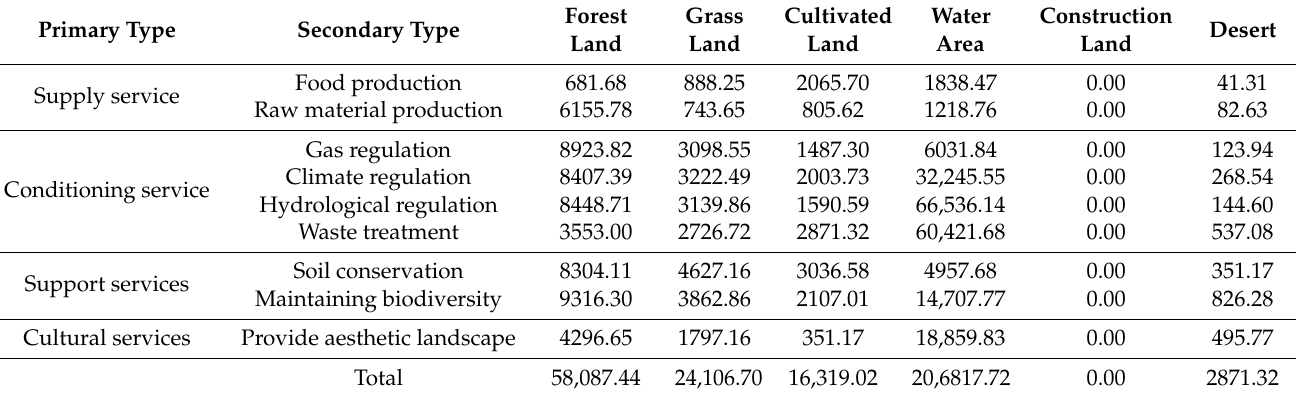
Table 2. Value of ecosystem services per unit area of land in CCCG (Unit: CNY/hm 2